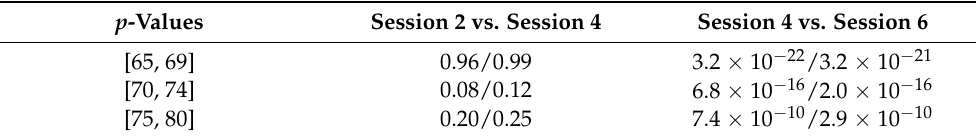
Table 4. Statistical tests (Mann–Whitney U/Wilcoxon) to assess changes in survey responses over time (sessions 2, 4, and 6). p -values in bold represent significant differences for α = 0.05. p -Values